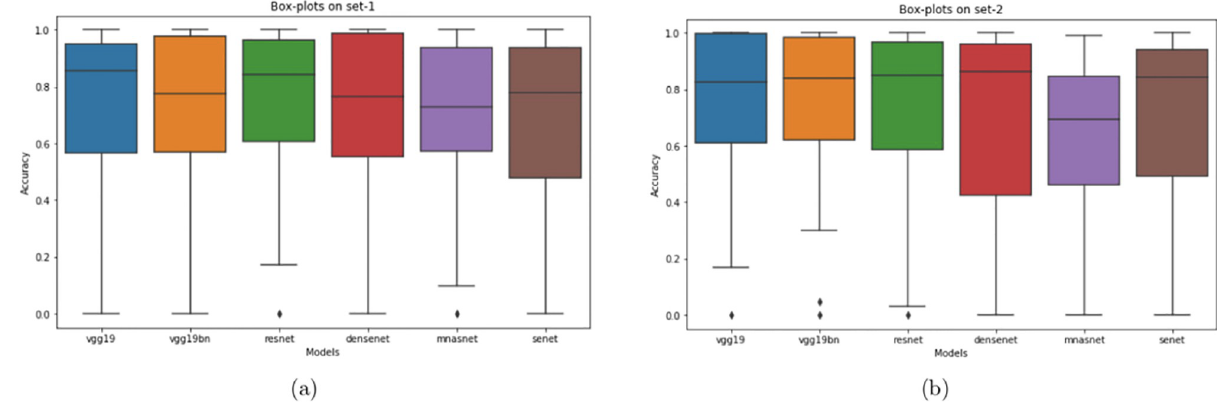
Fig 9. Box plot of set-1 and set-2: The accuracy per sequence distribution of different models on (a) set-1 and (b) set-2.